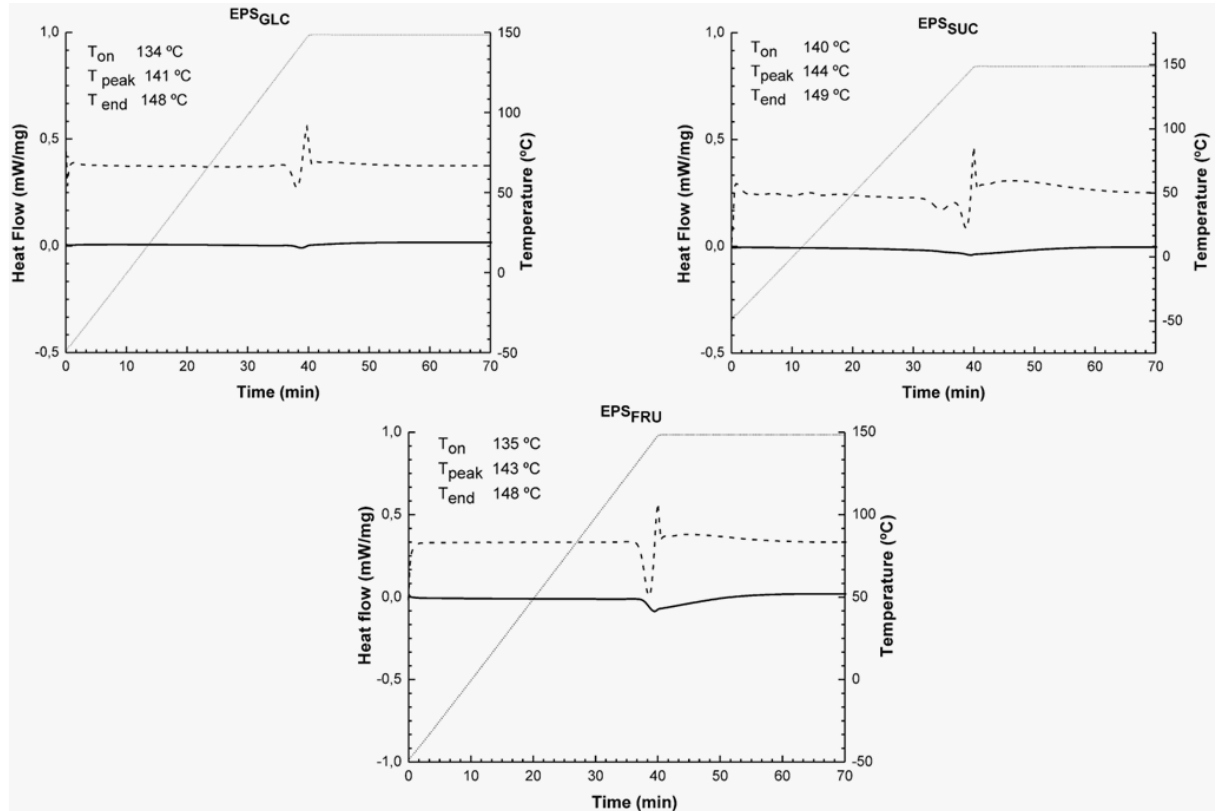
Figure 1. DSC (—) and DDSC (---) curves for botryosphaerans EPS EPS over the 50–150 °C temperature range. The heating rate was 5 °C/min, with an FRU isothermal hold at 150 °C for 30